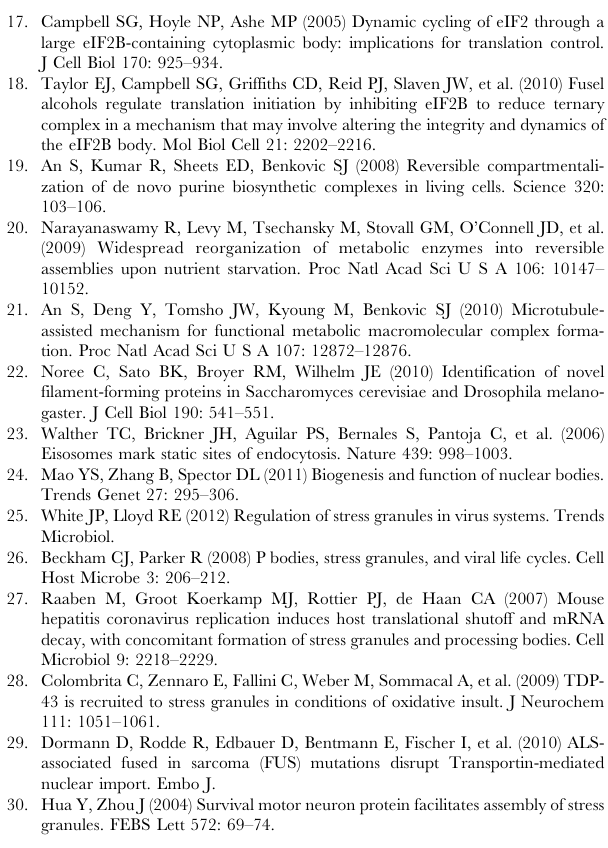
Figure S1 BUHO and manual analysis of cells and SGs. A representative region from the training set of images (see Table 1) is depicted through the whole process of nucleus, cell and SG identification. A, the DAPI staining is converted to a nuclear mask using the im2bw MATLAB function ( image to black and white ). The oligodT-Cy3 staining was negatively converted with the imcomple- ment function ( image complement ). The two matrices were combined to generate an image with black nuclei and bright cytoplasm. Then, the watershed transform algorithm ( watershed function) was used to delimitate the cell borders. B, The oligodT-Cy3 image was used to detect SGs similar to Prototype I. The pixel pattern of each pixel of the Cy3 image is compared with the pixel pattern of Prototype 1 by a normalized 2-D cross-correlation (normxcorr2) , which generate an image where each pixel has a value from 2 1 to 1, with 1 indicating the higher similarity. Then, a similarity threshold empirically adjusted to avoid false positives (see text) is applied and pixels with values higher than ST =0.89 are assigned a value of 1. These operations generate seeds in each hit. Finally, the imdilate function convert the seeds into larger objects, the identified SGs.